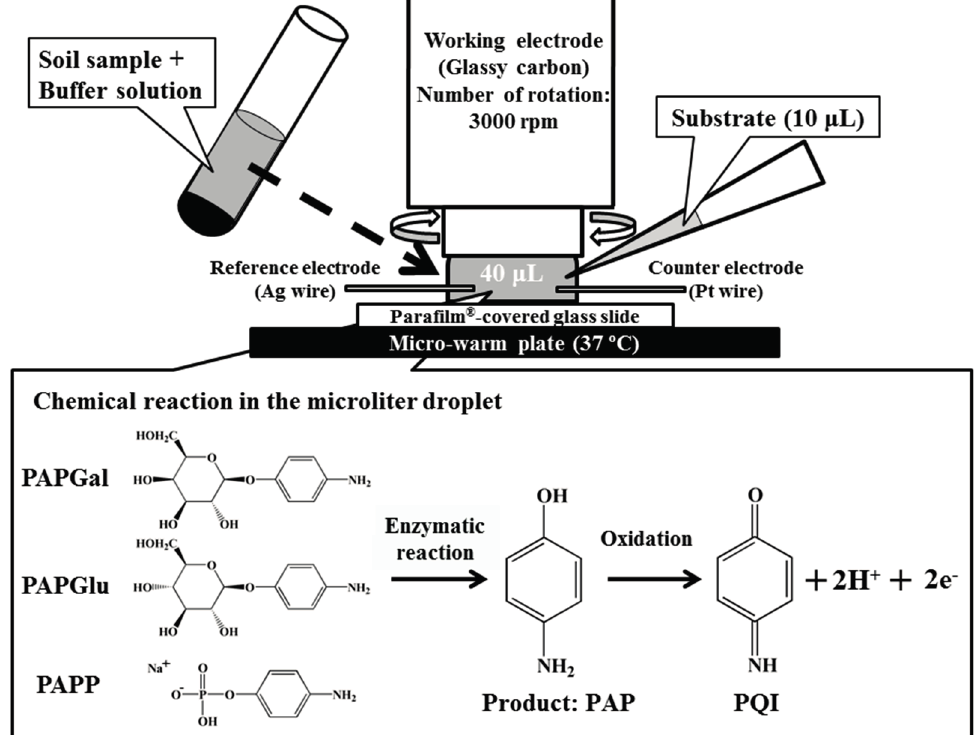
Figure 1. Schematic diagram of the enzyme assay with hydrodynamic voltammetry using a rotating disk electrode in a microdroplet. PAPGal: p -aminophenyl- β - D